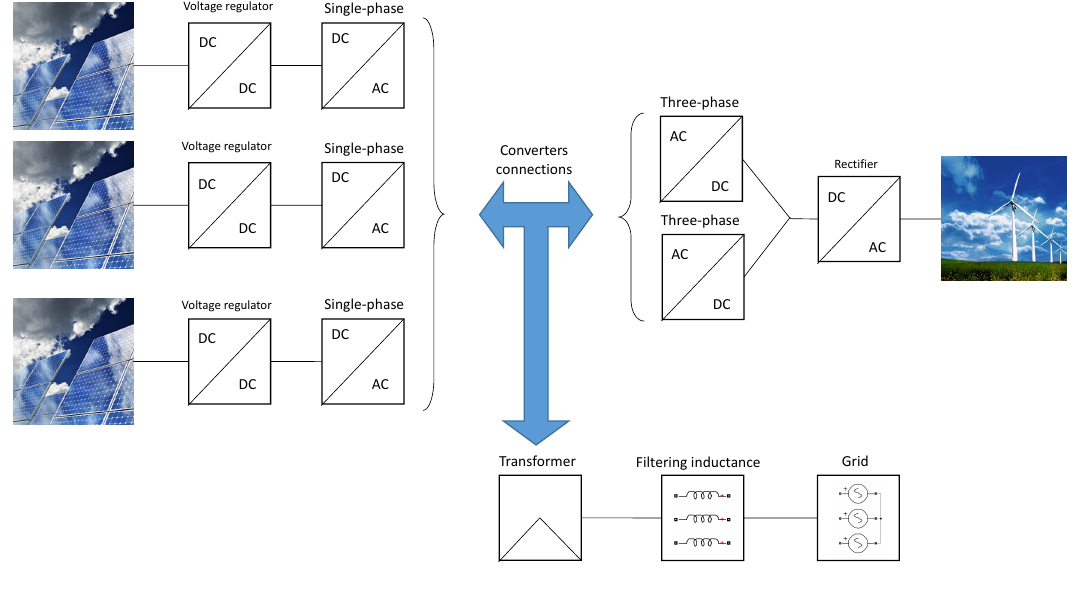
Figure 1. Schematic representation of the studied